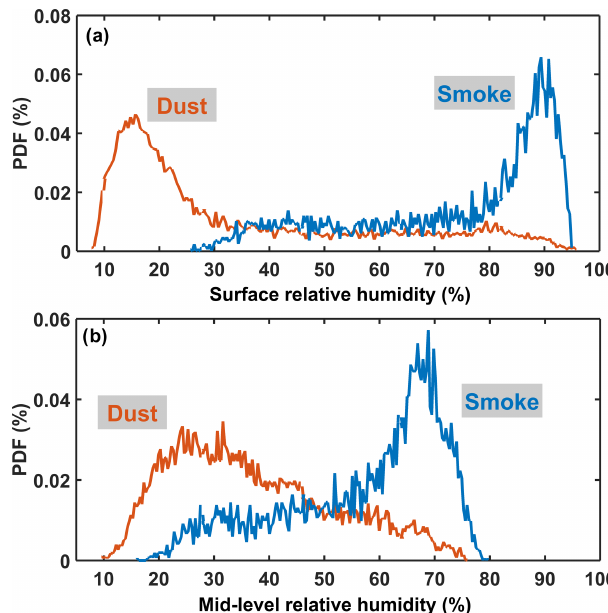
Figure 4. The probability density function (PDF) of (a) surface and (b) mid-level relative humidity in the dust- and smoke-dominant